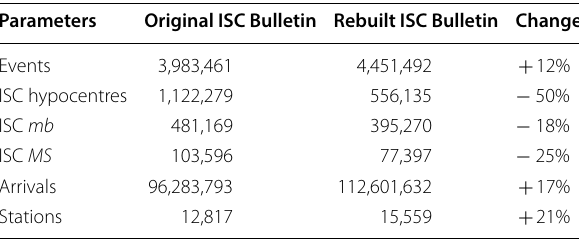
Table 1 Comparative analysis of rebuild versus original